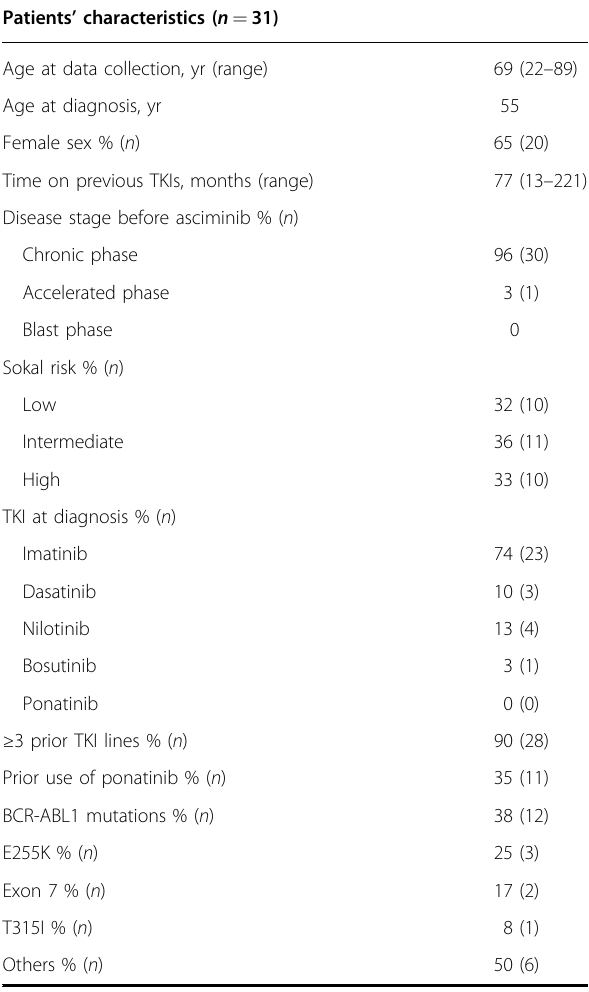
Table 1 Patients baseline characteristics. Patients ’ characteristics ( n =